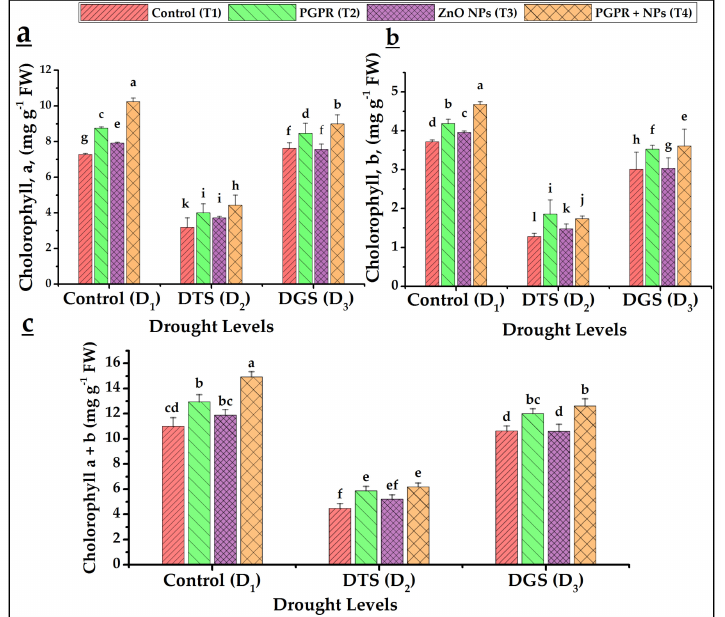
Figure 1. The effects of PGPR and NPs application on foliar chlorophyll contents on wheat under drought. ( a ) Chlorophyll a, ( b ) Chlorophyll b, ( c ) Total chlorophyll content. DTS = drought at tillering, DGS = drought at grain filling, T 1 = control, T 2 = single use of Azospirillum brasilense , T 3 = single use of ZnO NPs, and T 4 = co-application of PGPR and NPs. Error bars indicates standard error ( n = 3). (Note: Different lowercase letters indicate significant differences between different drought levels and treatments by the LSD test at p <